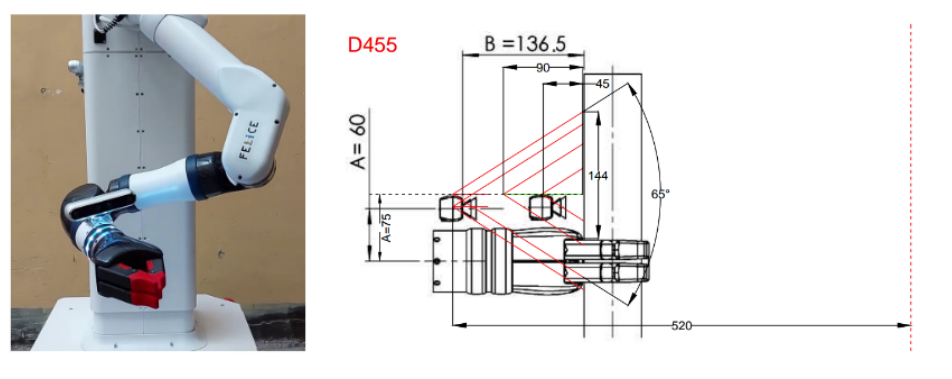
Figure 4. On-robot camera. The ( left ) image depicts the Intel RealSense D455 camera mounted on the robot arm. The ( right ) image illustrates the investigation of the optimal placement of the Intel Realsense D455 camera on the robot arm. All the dimensions shown are in mm. The dashed red line on the right represents an object to be localized.